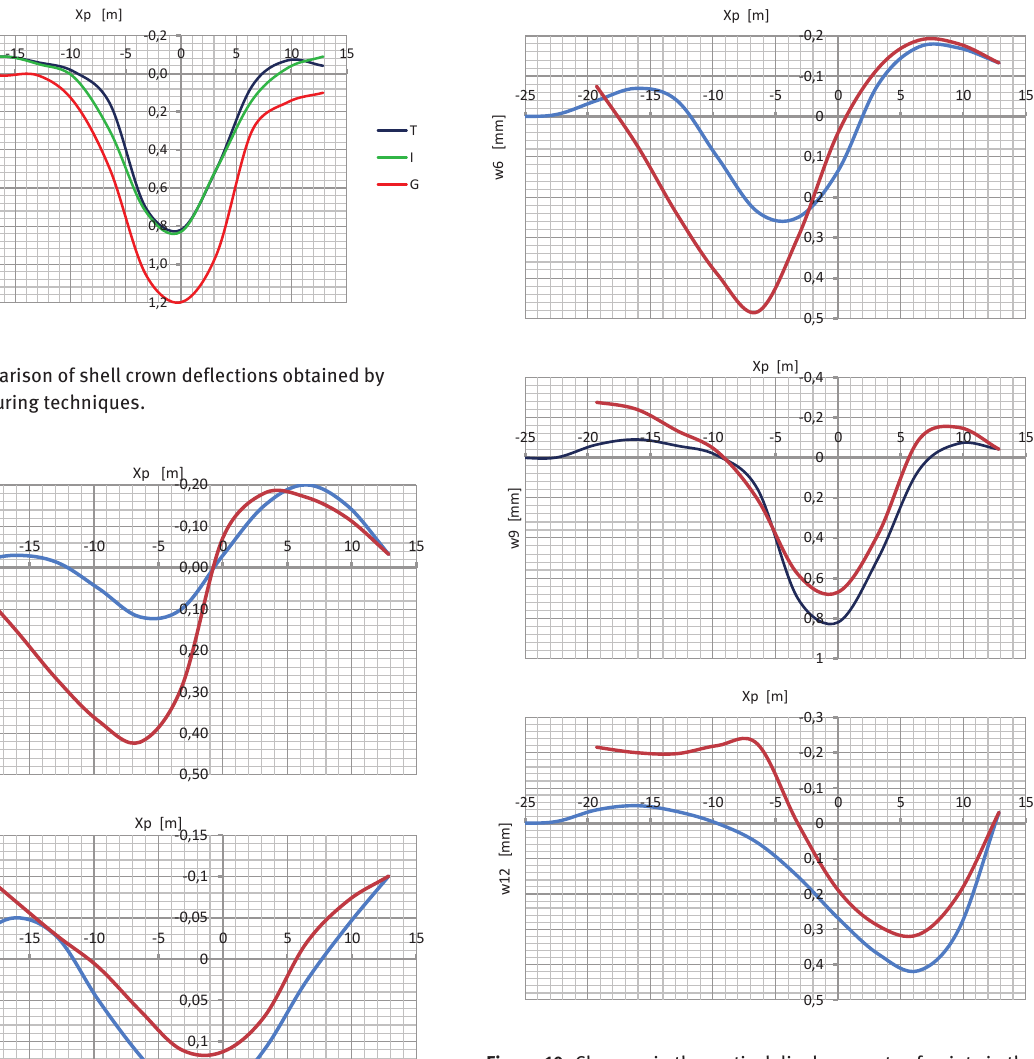
Figure 10: Changes in the vertical displacements of points in the shell crown area during the travel of